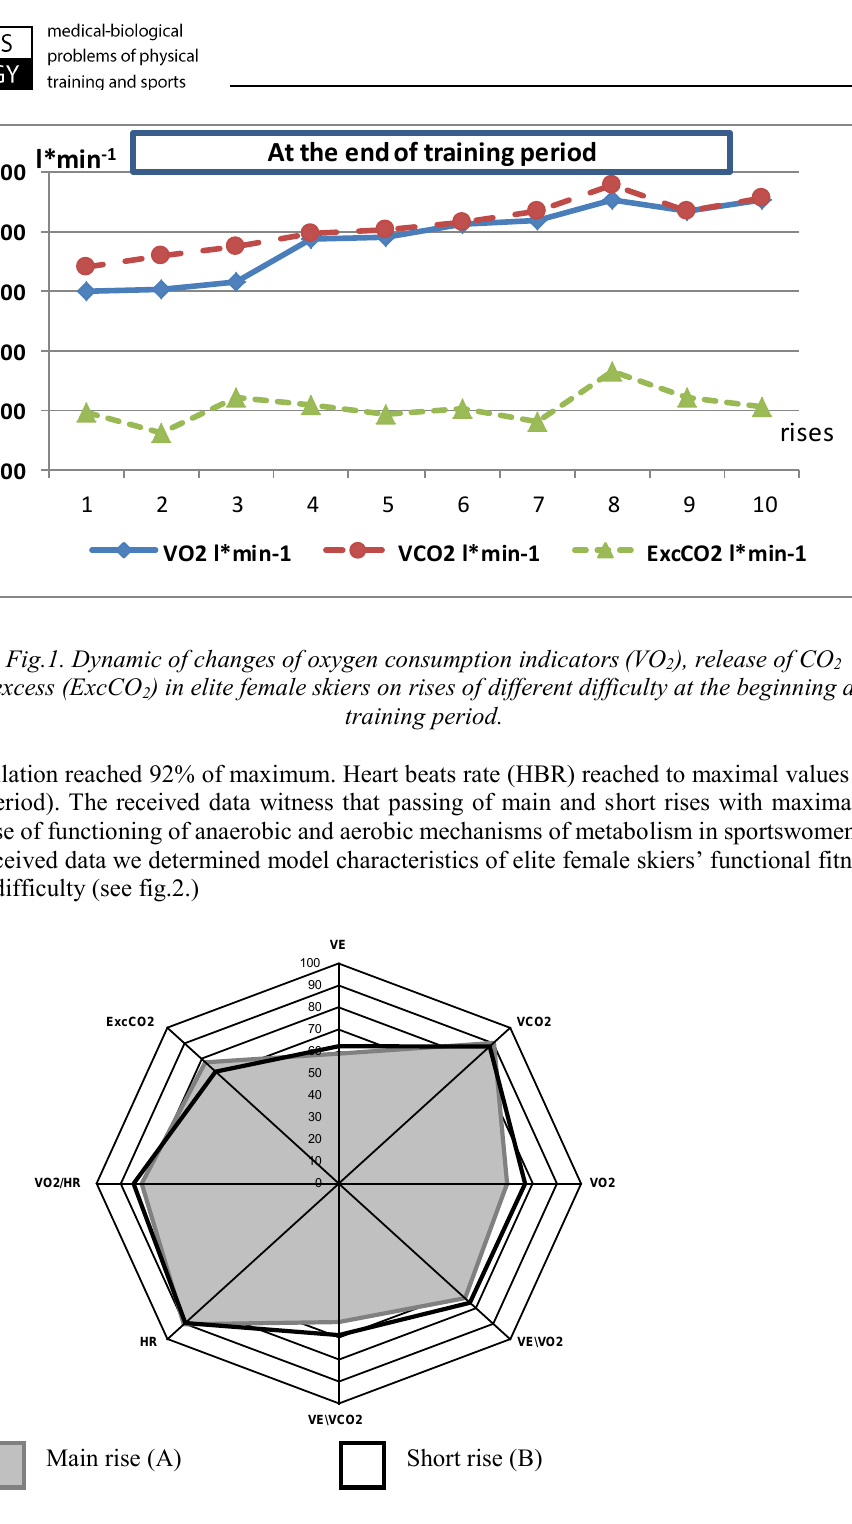
Fig.2. Model functional characteristics of female skiers on rises of different difficulty (% from maximal